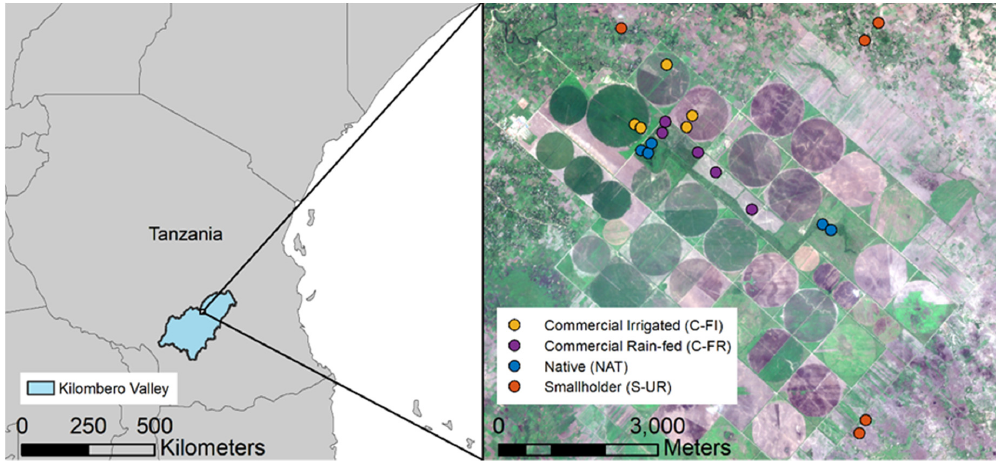
Figure 1. Soil sampling locations (sites) on and around the Kilombero Plantations Ltd farm.